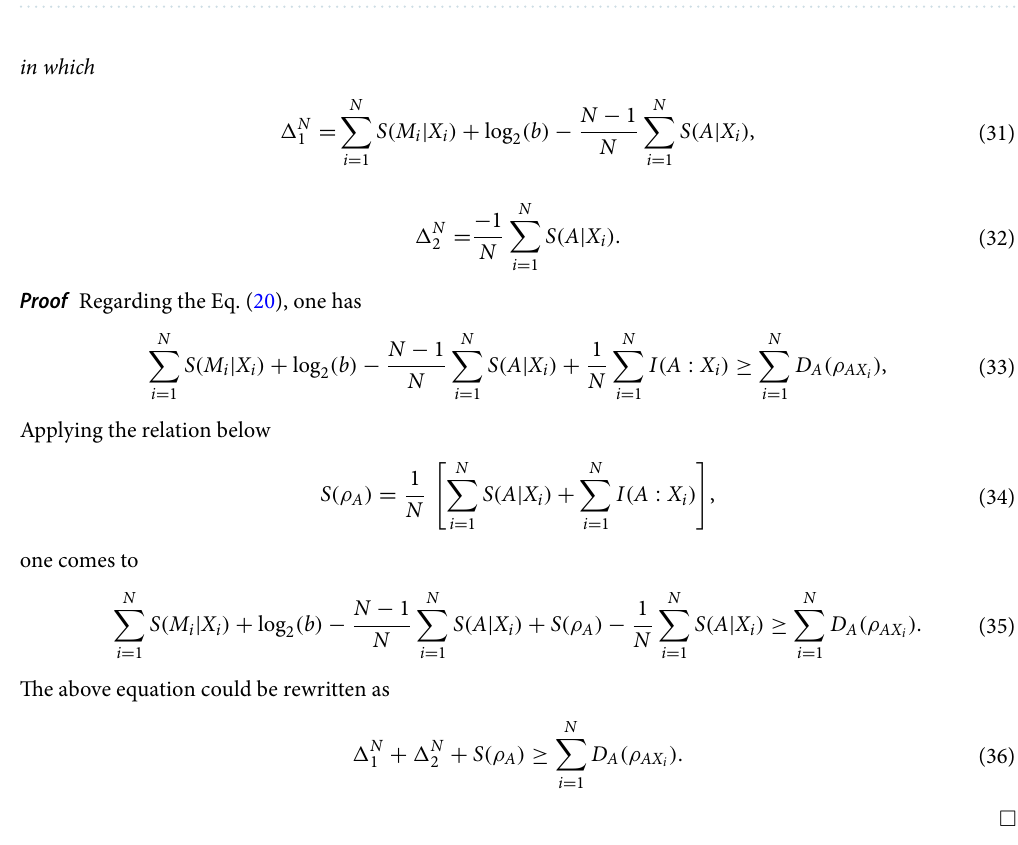
Figure 4. Different upper bounds on the shareability of QD for the state in Eq. (29), versus the state’s parameter 1 . The solid-red curve stands for Hu and Fan upper bound and the dashed-green curve p p , where 0 ≤ ≤ 0 and p 1 , there is a pure state, our bound completely coincides with indicates our upper bound. Since for p = = that of Hu and Fan. However, the curves illustrate that for 0 < p < 1 , our obtained upper bound is tighter than that of Hu and